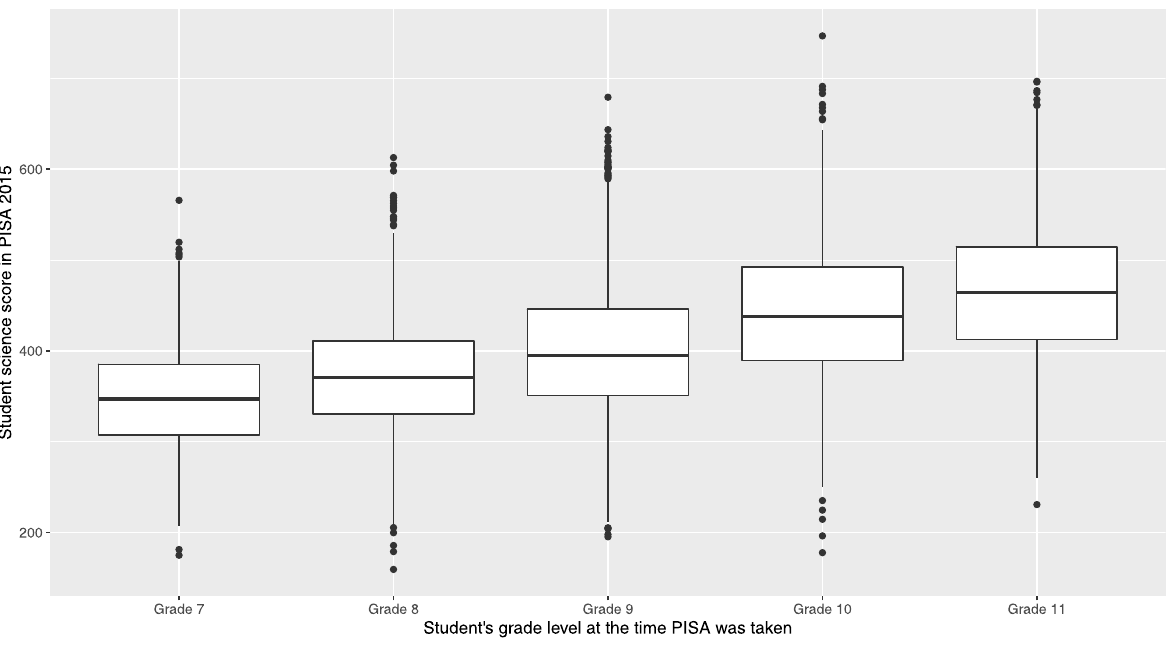
Fig. 4 Science scores of Colombian students in PISA 2015 by